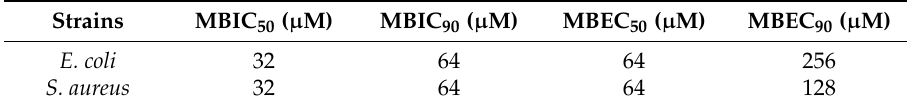
Table 2. The antibiofilm activity of Dermaseptin-PH against E. coli and S. aureus . Strains